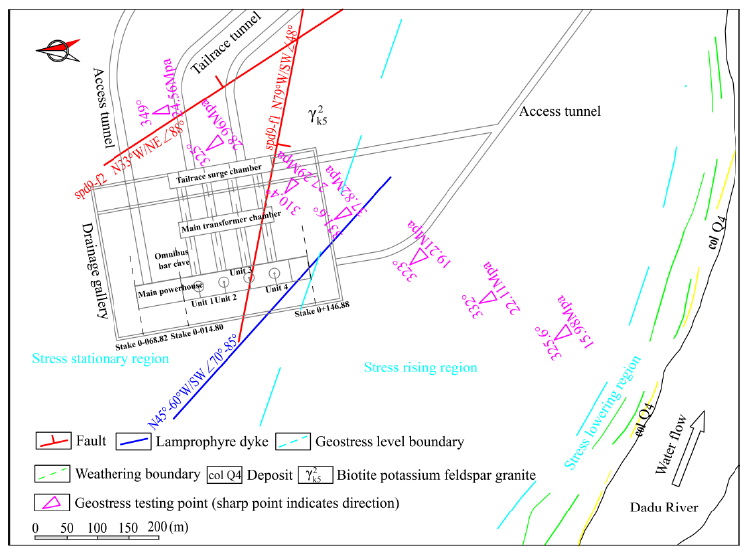
Figure 2. Geological horizon slice map of the plant area at a height of 2268 m [29]. Table 2. Geostress classification.